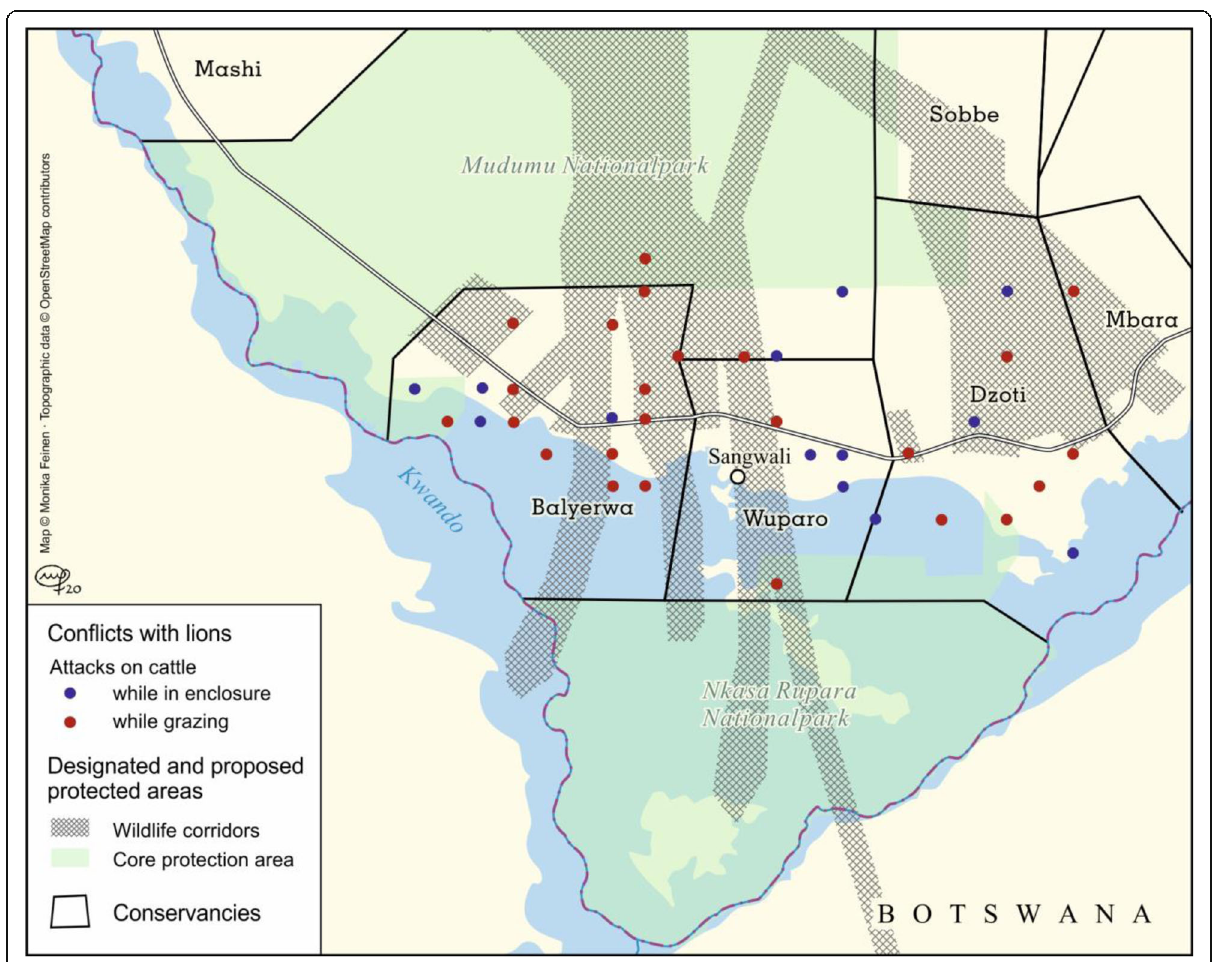
Fig. 4 Game corridors and conservation areas in Mudumu South and cattle – lion